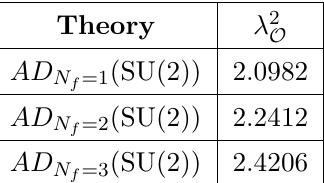
Table 2 . Numerical values of the OPE coefficient λ 2 only F and F 0 1